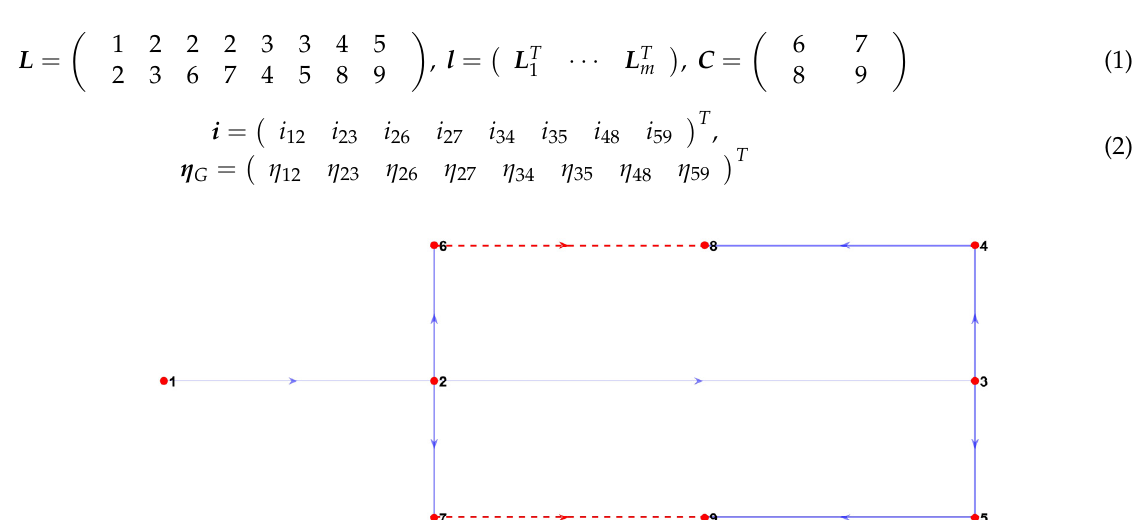
Figure 3. Graph of mechanical links.